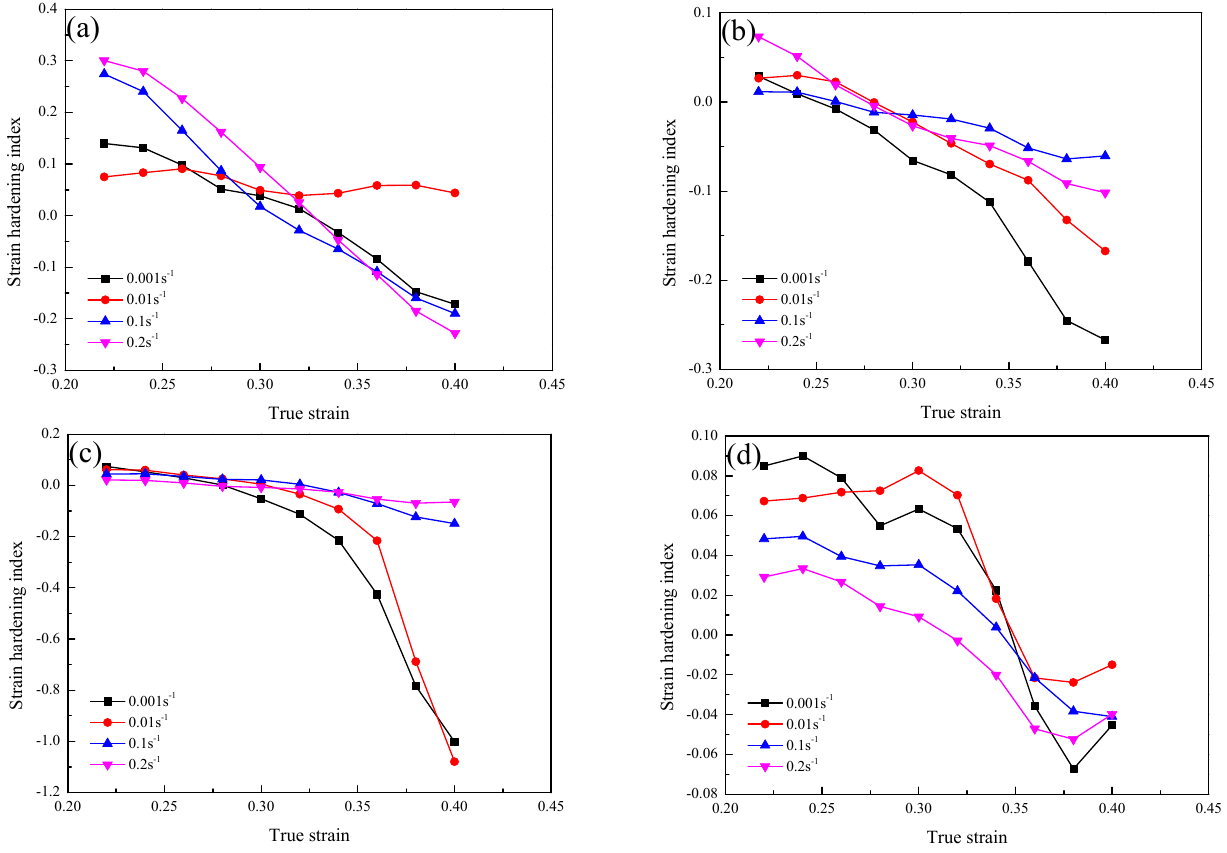
Figure 5. Strain hardening index of the GH3230 superalloy double-sheet deformed under different deformation temperatures: ( a ) 1123 K; ( b ) 1173 K; ( c ) 1223 K; ( d ) 1273 K.